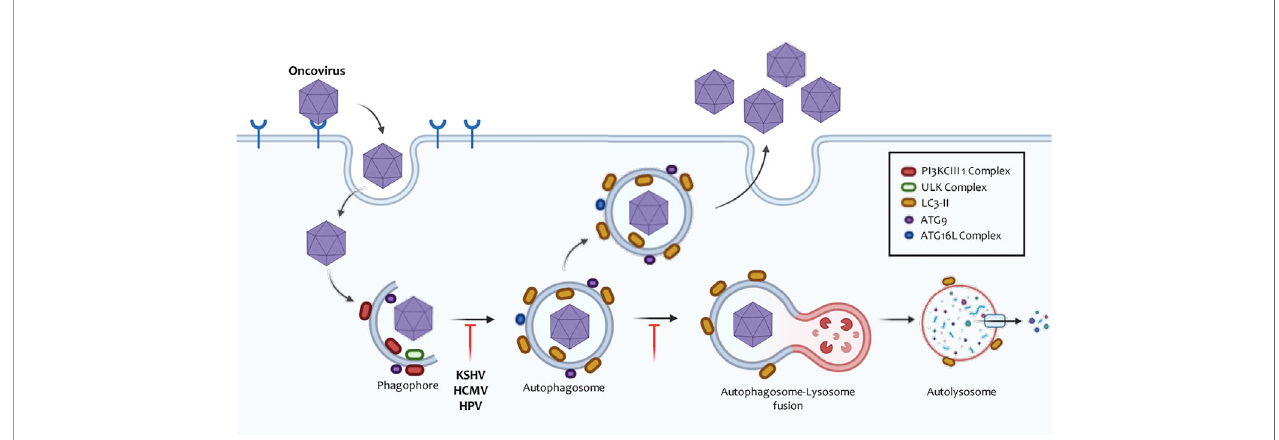
FIGURE 5 | Manipulation of autophagy by oncoviruses. Oncoviruses regulate autophagosome formation or degradation in order to promote their replication cycle. Like many DNA viruses, Herpesviruses prevent their degradation by inhibiting the creation of these vesicles, whereas RNA viruses often induce the accumulation of autophagic membranes independent of their replication in the cytosol or the nucleus. These autophagic membranes can form autolysosomes and fi nally conclude. In other cases, the autophagic membranes may be used as scaffolds, where the viral replication complexes are positioned or serve as support for the release of the particles. Poliovirus was the fi rst virus where this mechanism has been